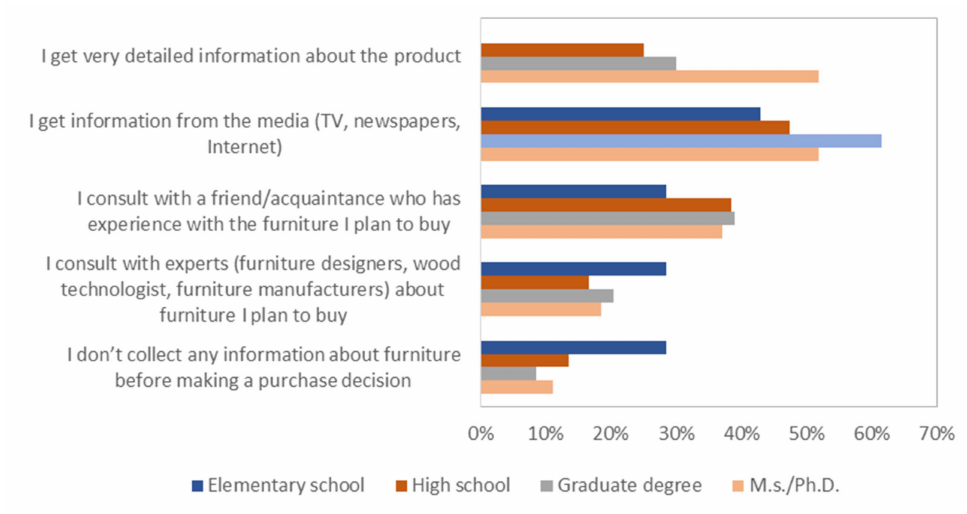
Figure 4. Consumer way for collecting information regarding education ( N = 400).